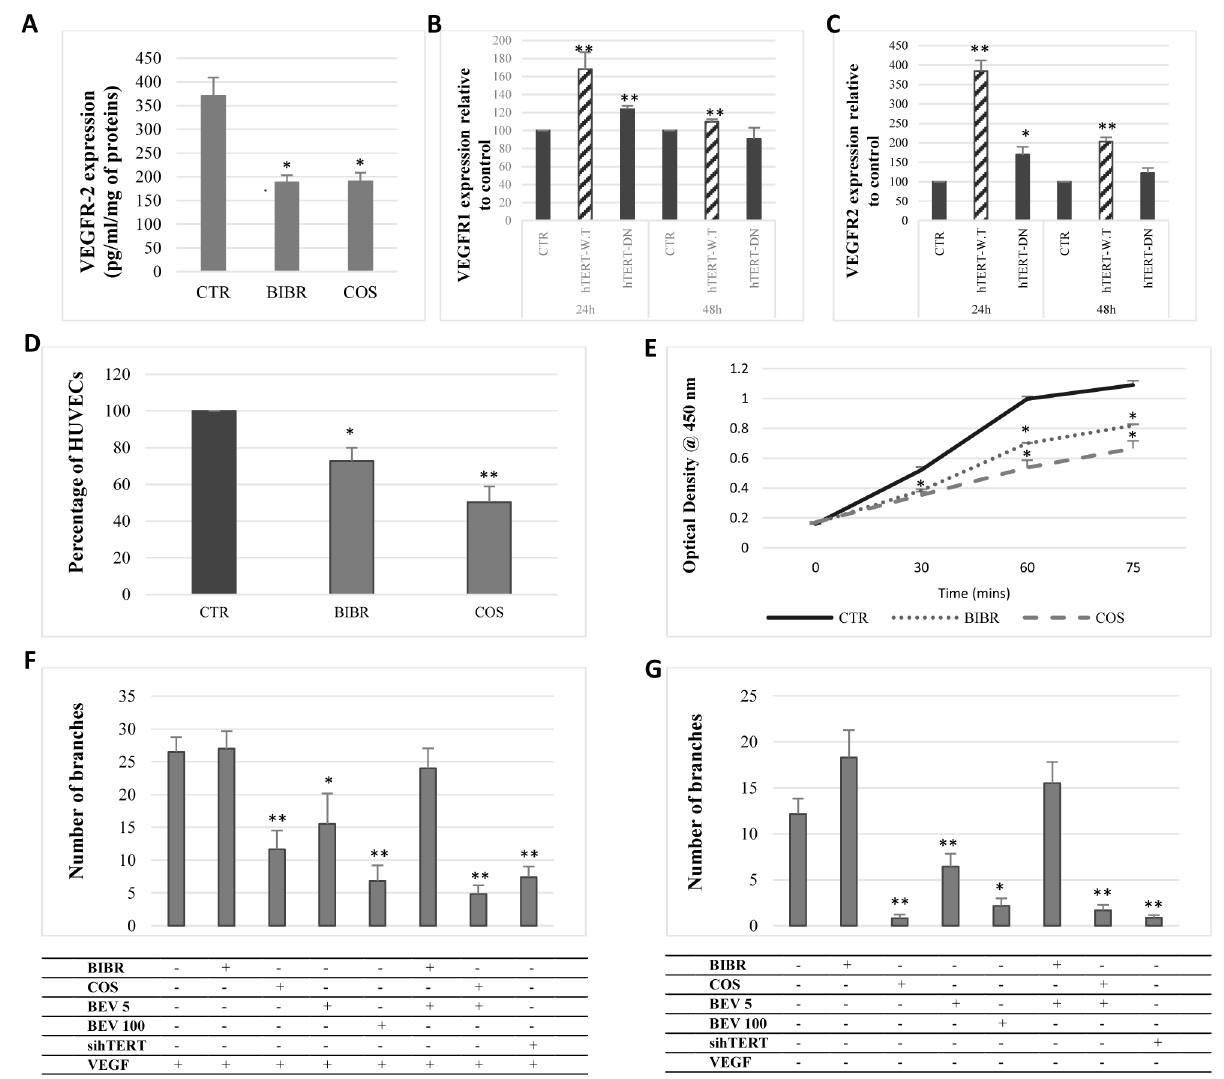
Fig 6. Telomerase inhibition decreasesthe proliferation and tube formation of HUVECs. (A) HUVECs were treated with BIBR-1532 and costunolide. VEGFR2 protein levels were quantifiedby ELISA using the cell protein extracts. (B, C) HUVECs were transiently transfected with either a control siRNA or hTERT siRNA for 72 h. VEGFR1 and VEGFR2 expressionwas then assessed by real-time PCR. (D) HUVECs treated with BIBR-1532 and costunolide were collectedand countedusing trypan blue. (E) HUVECs were cultured in a 96-well plate and treated with telomerase inhibitors. Tetrazoliumsalt was added to each well and changesin absorbance followingformazan formation was detected at 450 nm. (F, G) HUVECs were cultured on an ECM in the presenceof recombinant VEGF 165 (50 ng/ml), telomerase inhibitorsand bevacizumab. Capillary-like structures were quantifiedin the presence(F) and absence(G) of recombinant VEGF 165 .Values are represented as the mean ± SE of 10 randomly chosen